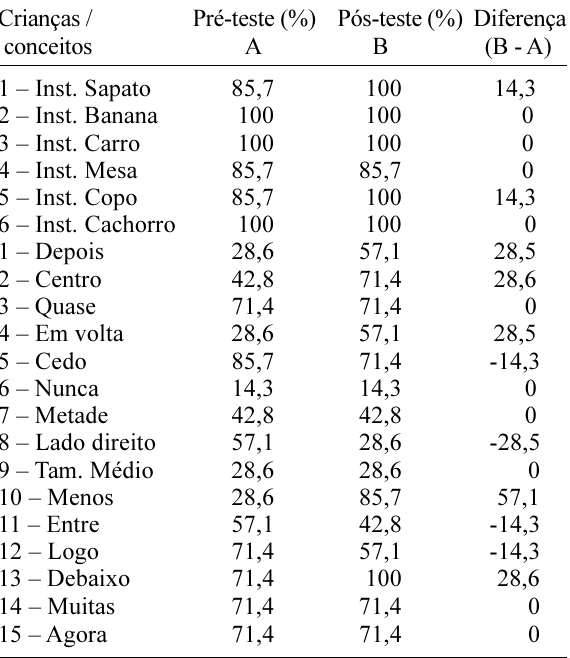
Comparação entre os Resultados do Teste de Boehm Adap- tado Obtidos no Pré-teste e no Pós-teste pelas Crianças com Paralisia Cerebral Crianças